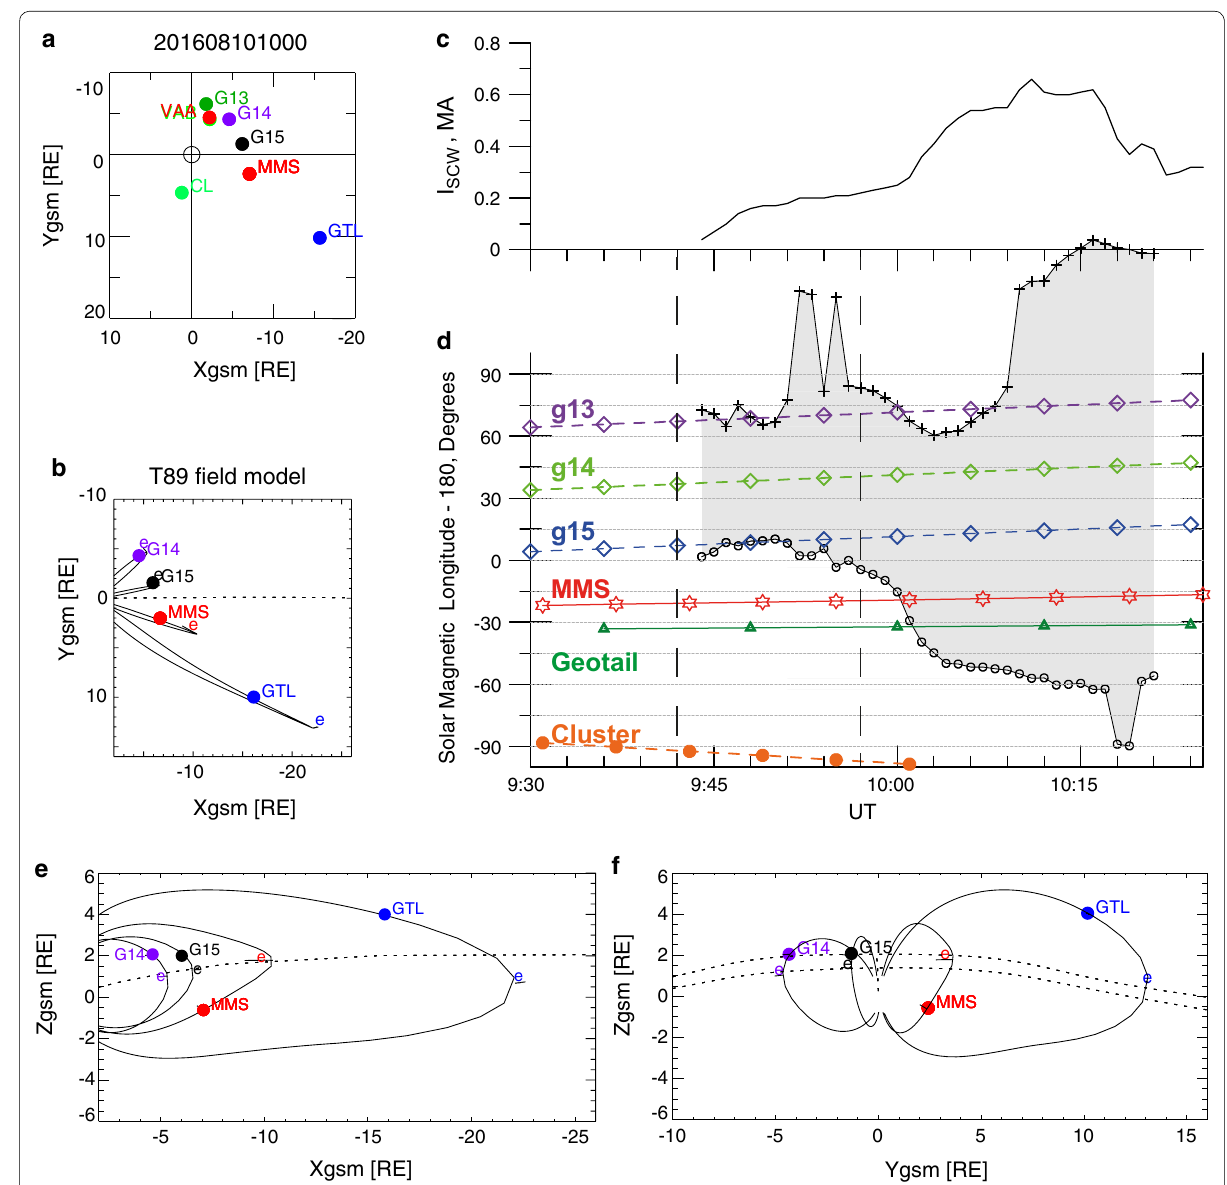
Fig. 1 Spacecraft location and magnetic field model field lines from the T89 model at 10:00 UT on August 10, 2016, and location of SCW. a Location of VAA and VAB ( red and green ); GOES 13, 14, and 15 ( green , purple , and black ); MMS ( red ), Cluster 1 ( light green ); Geotail ( dark blue ) and b MMS, GOES 14 and 15, Geotail, and traced field lines using the T89 model projected in a GSM X – Y plane. c Total current of the SCW and d magnetic local time of the SCW and spacecraft obtained using the SCW model (Sergeev et al. 2011). Location of MMS, GOES 14, 15, Geotail, and traced field lines using T89 model projected ( e ) in the GSM X – Z plane and f in the GSM Y – Z plane. The location of the equator is denoted by “ e ”. The dotted line in e indicates the location of the equatorial plane in the midnight meridian ( Y 0), whereas those in f show the equatorial plane at X 10 R E ( upper curve ) and = = − X 7 R E ( lower curve = −